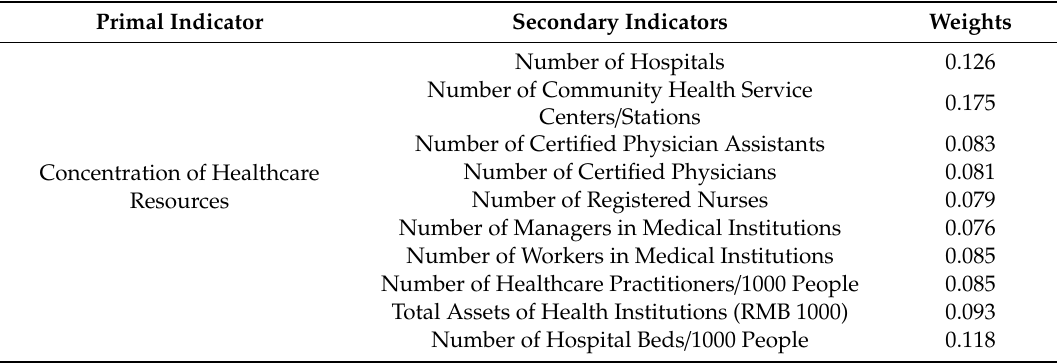
Evaluation Indicator System of Healthcare Resources Concentration and the Corresponding Weights. Primal Indicator Secondary Indicators Weights Number of Hospitals